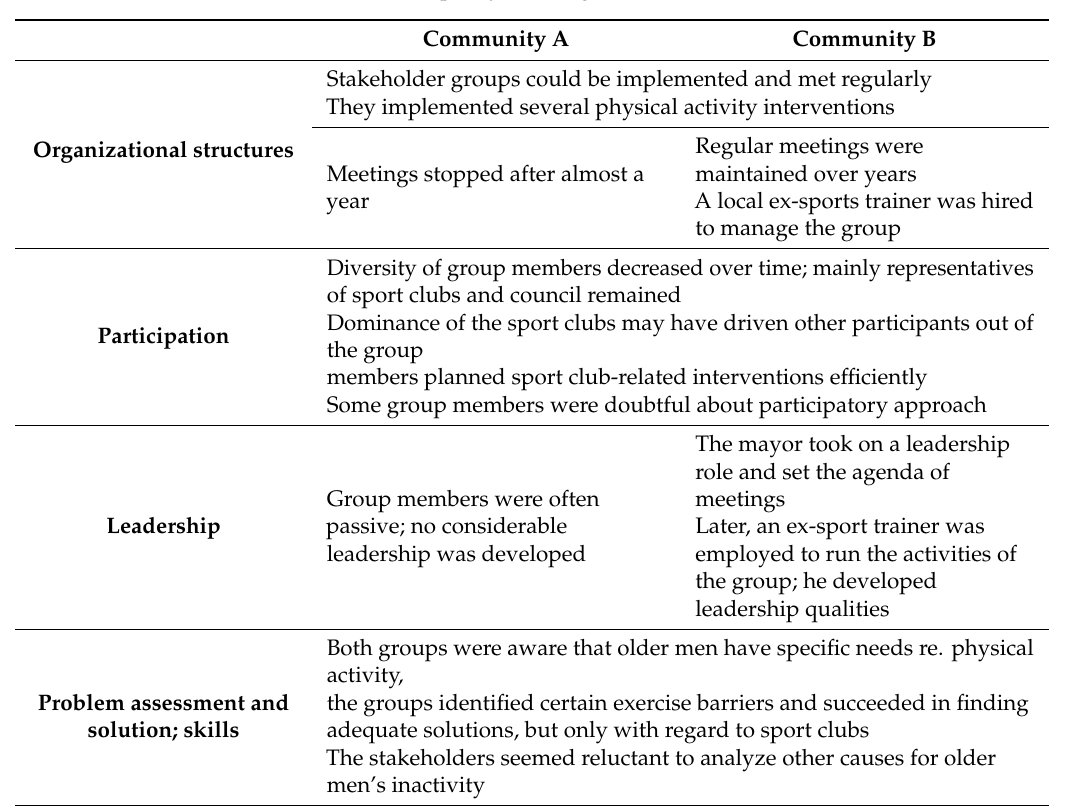
Table 4. Di ff erences in capacity building between both